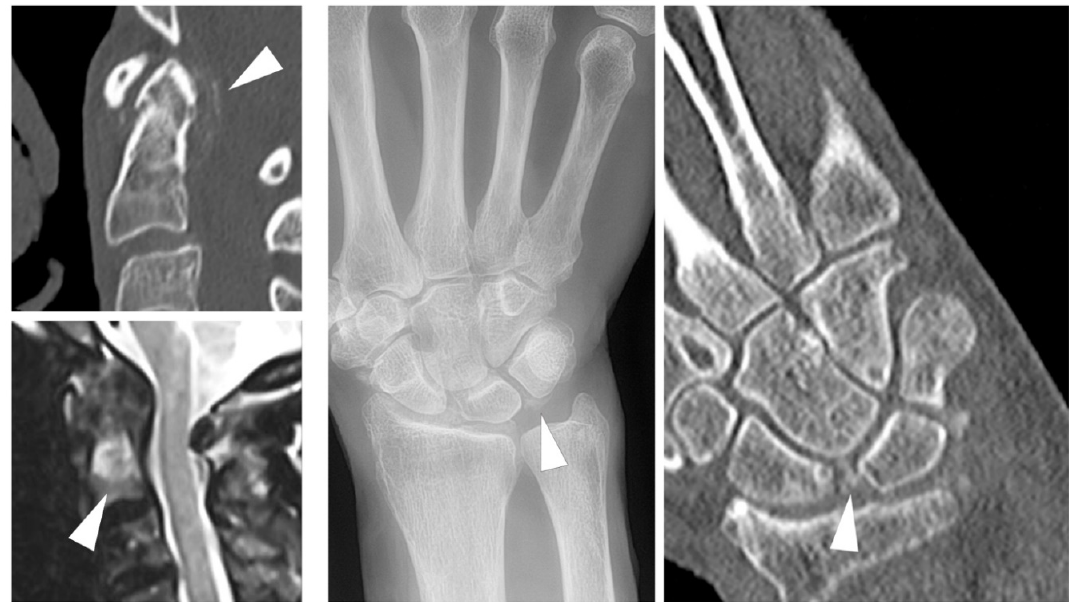
Figure 3. Multimodality imaging in Calcium Pyrophosphate Dihydrate Deposition (CPPD). ( Left ): Crowned dens syndrome with flake-like calcifications in the CT image (arrowhead) and concurring bone marrow edema on MRI (arrowhead). ( Right ): CPPD of the wrist, showing calcifications of the luno-triquetral ligament on radiography and additional calcifications of the scapho-lunate ligament on CT (arrowhead).